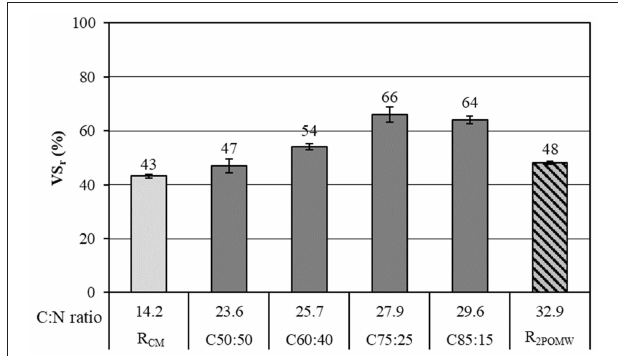
FIGURE 2 | Organic matter removal, expressed as percentage of total volatile solids (VS r ), in the co-substrates and